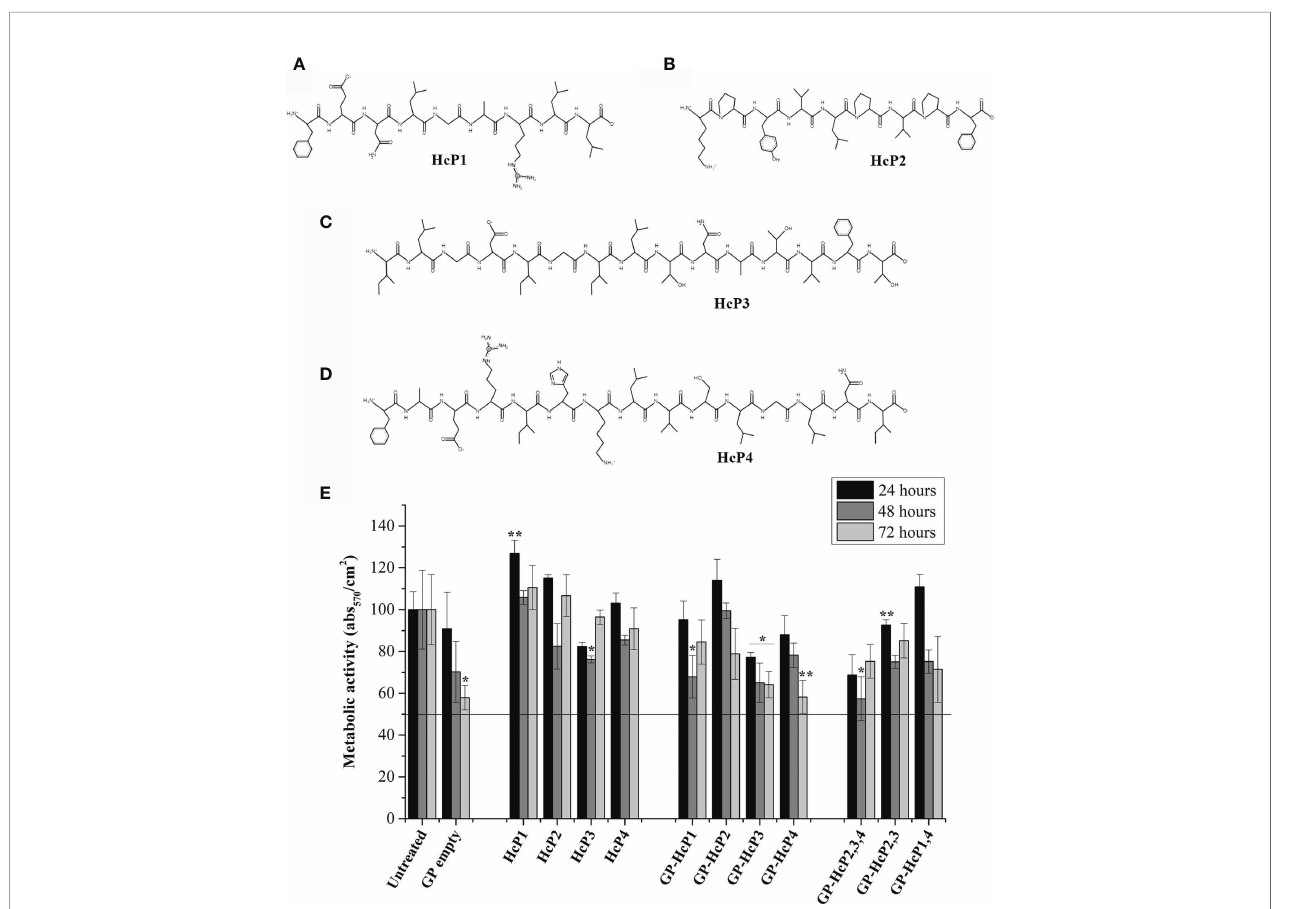
FIGURE 6 | Chemical structure of the synthesized peptides and their effects on the viability of the Jaws II cells. The chemical structures of (A) HcP1 (HSP60), (B) HcP2 (enolase), (C) HcP3 (HSP60), and (D) HcP4 (HSC82) were obtained by PepDraw server. (E) Effects of HcP 1-4 tested from 10 µg/200µL, GP-HcP 1-4 and GP-HcP 2,3,4; 2,3 or 1,4 tested at 5 µg/200µL for 24 and 48 hours. The percent cell viability (%CV) was calculated from the absorbance values obtained by the microplate reader at 570 nm, according to the following equation: %CV = (Treated sample/Blank) x P100, where Blank and P100 represent, respectively, the negative control containing only culture medium and positive control containing the untreated cells, considered to be 100% cell viability. Difference from positive control by the Tukey ’ s test, *p < 0.05 or **p <